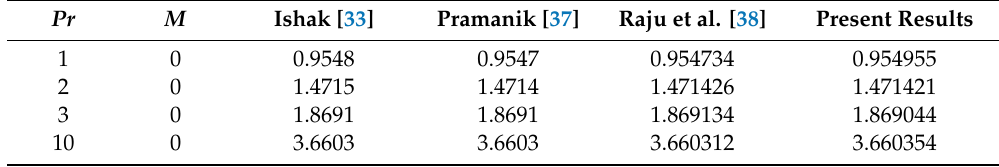
Table 1. The comparison of values of heat transfer rate for di ff erent values of Pr . Pr M Ishak [33] Raju et al.